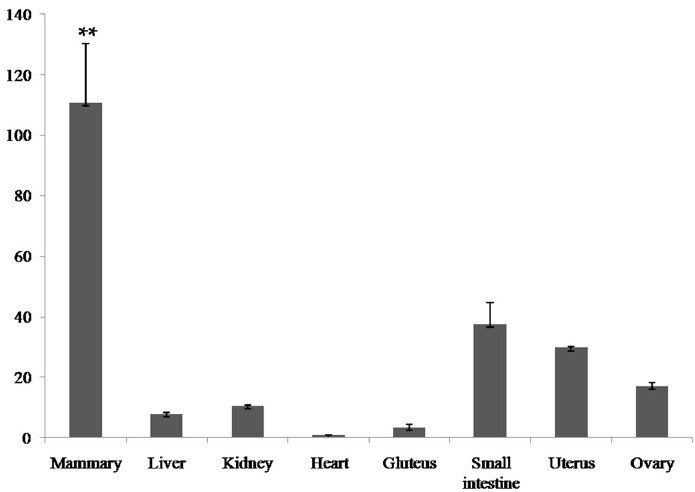
Figure 2. Relative quantification of the PDE9A gene in eight tissues. ** above the bars indicates significant difference between tissues ( p < 0.01).